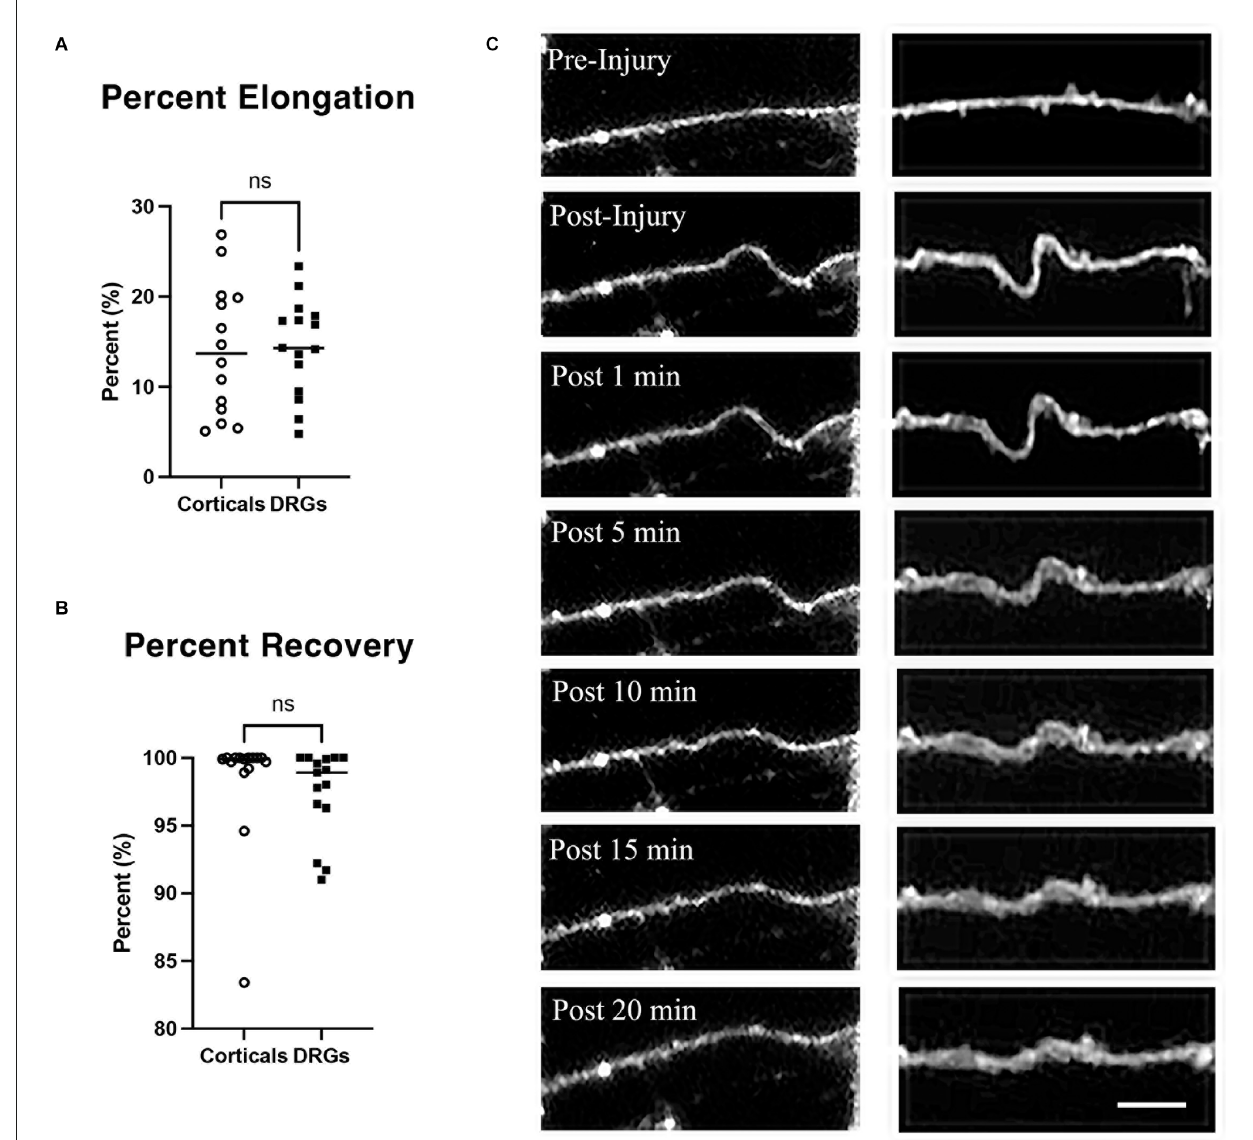
FIGURE2 Axon elongation and recovery. (A) Cortical and DRGN axons elongated the same amount from a stretch of 60% strain, p = 0.90. (B) Cortical and DRGN axons recovered similarly 20 min after stretch, p = 0.50. Horizontal lines in (A) and (B) indicate the average of each group. (C) Time series of axon undulation and recovery. Axons fluorescently labeled with Fluo-4 AM prior to stretch injury. Left : cortical axon, right : DRGN axon. Scale bar = 10 µ m, ns = not